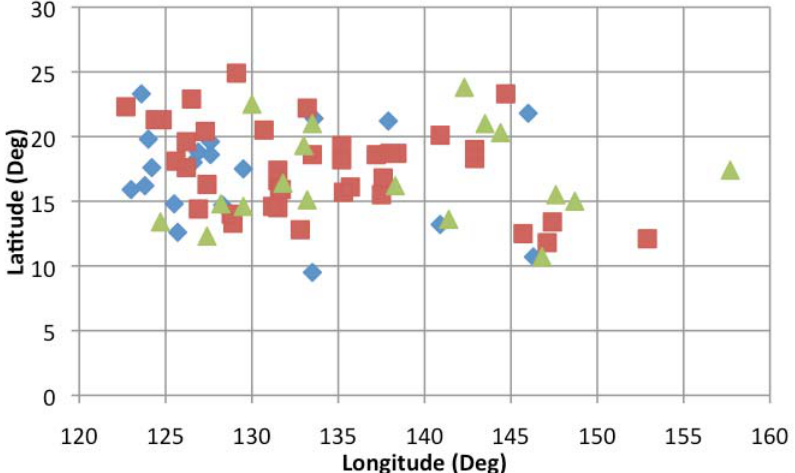
Figure 1. Locations (north latitude and east longitude) at which minimum sea level pressure (MSLP) was reached for typhoons with minimum MSLP <905 hPa. Green triangles are for El Nino years, blue diamonds are for La Nina years, and red squares are for neutral